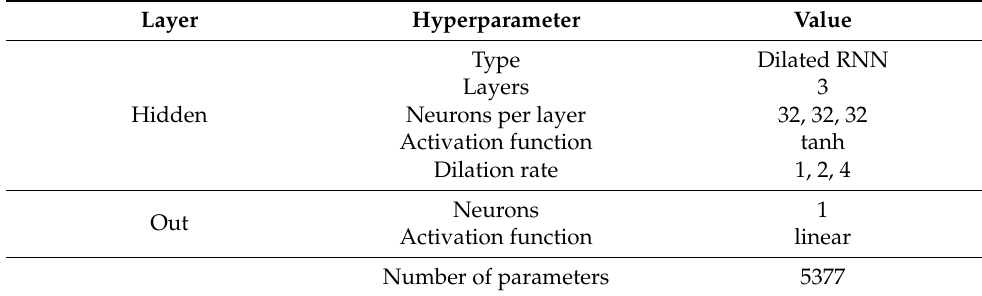
Table 7. Zhu’s architecture hyperparameters